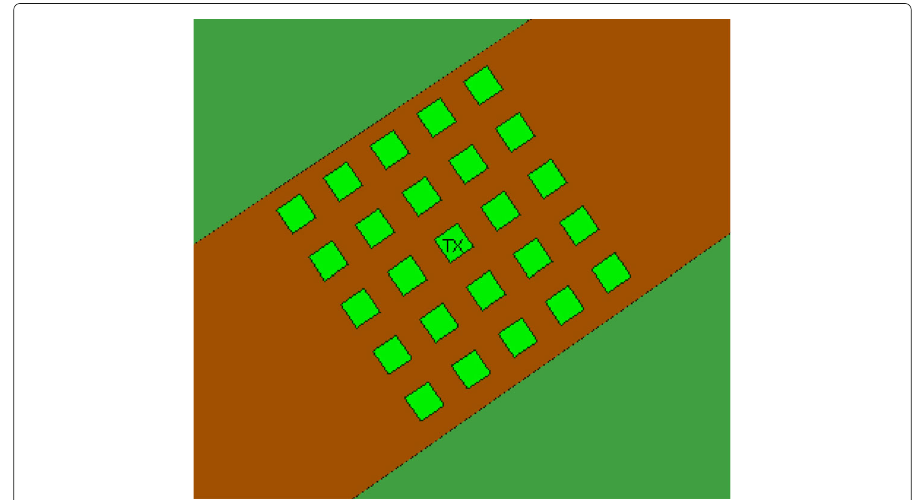
Fig. 17 Schematic diagram of sampling